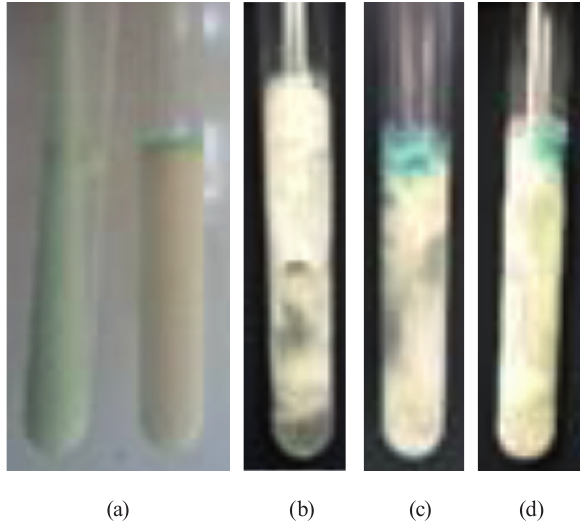
Figure 1 Four types of clots. (а) MBRTe-I (homogeneous solid/liquid clot), (b) MBRTe-II (lumpy clot), (c) MBRTe-III (gaseous clot), and (d) MBRTe-IV (lumpy + gaseous